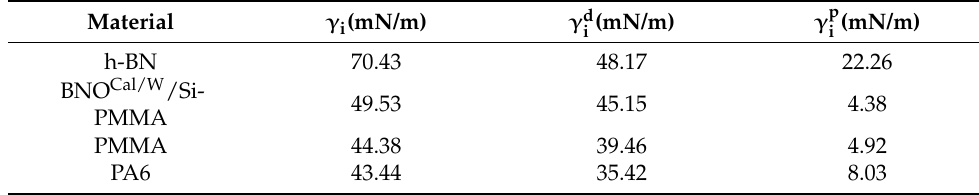
Table 3. Surface tension values of components of the blends.